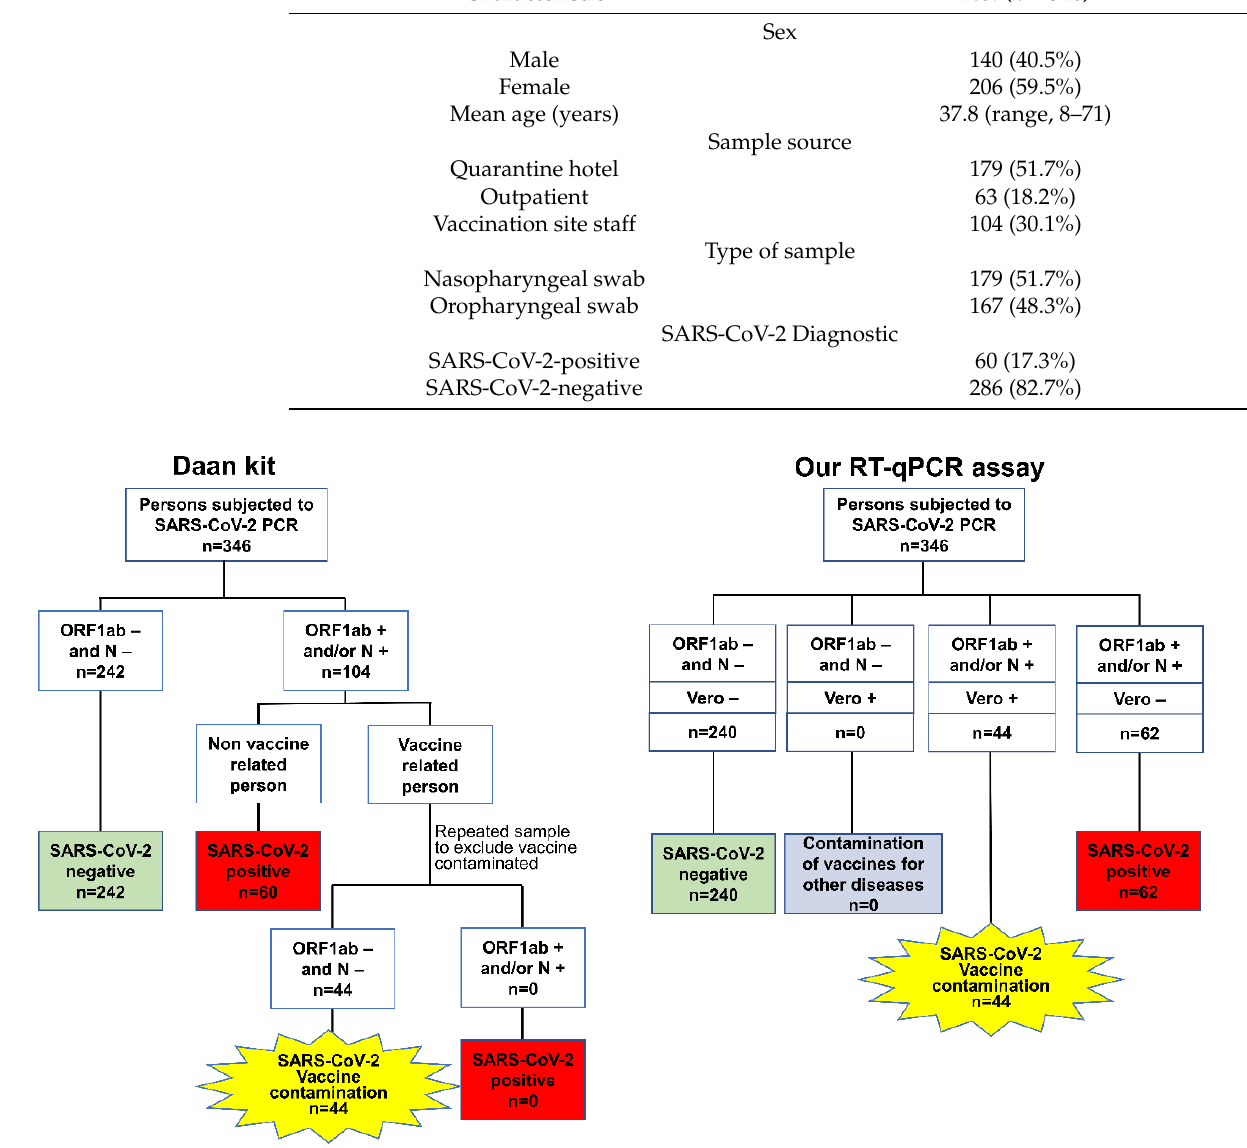
Figure 4. The results of the Daan kit and our RT-qPCR assay according to the interpretation flow chart. Table 3. SARS-CoV-2 diagnostic performance of our RT-qPCR assay for 346 clinical